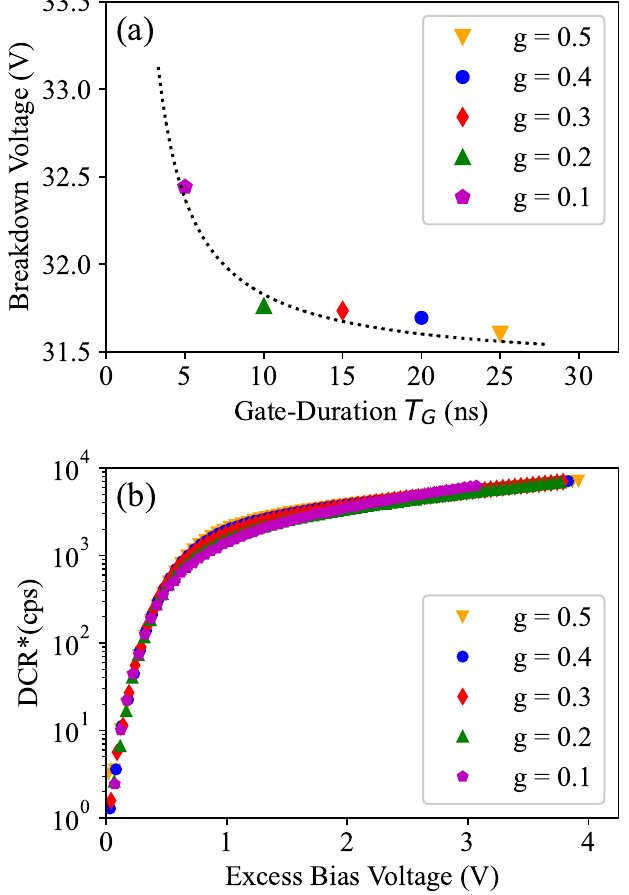
Figure 5. ( a ) Calibrated breakdown voltage as a function of the gate-ON time. ( b ) Total (maximum) dark-count rate after breakdown calibration as a function of the excess bias voltage at different g